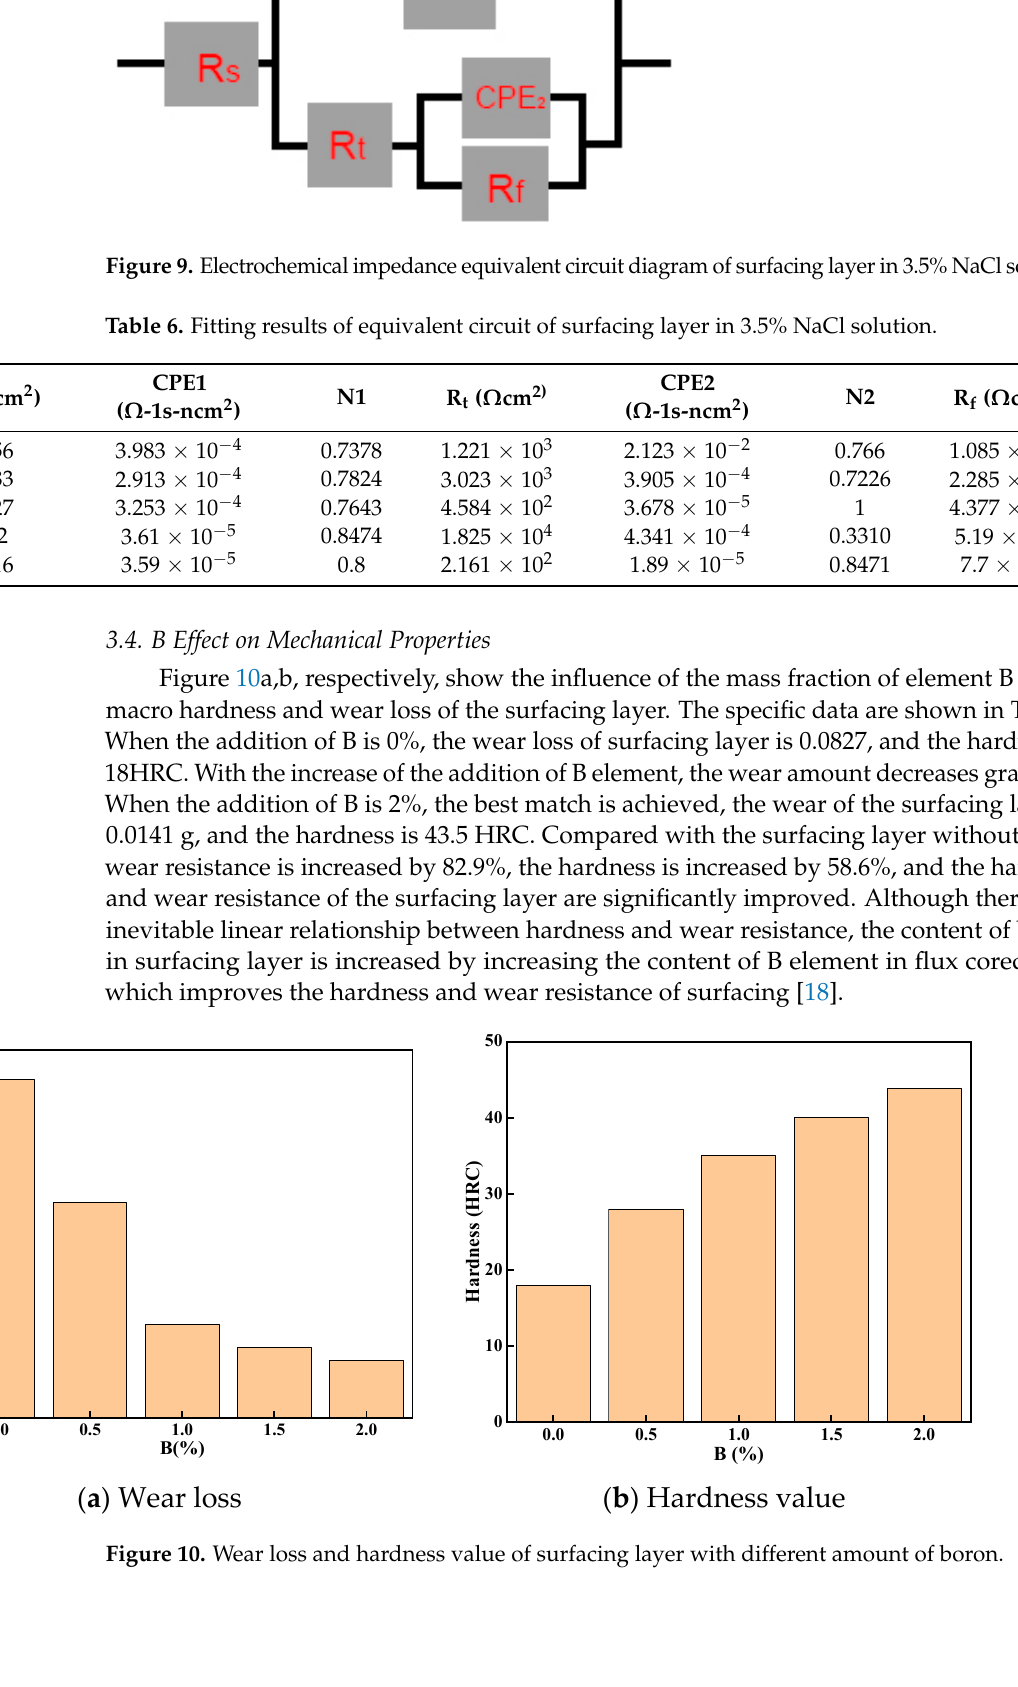
( a ) Wear loss ( b ) Hardness value Figure 10. Wear loss and hardness value of surfacing layer with different amount of boron.